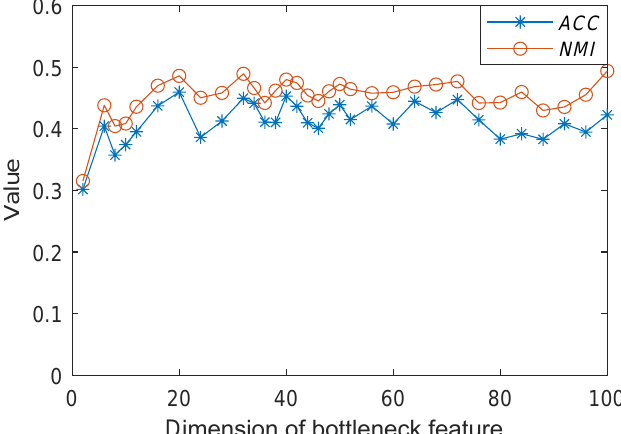
Figure 3. The effect of the dimensions N B of the bottleneck features produced by MAESC on the average channel on performance in terms of ACC and NMI